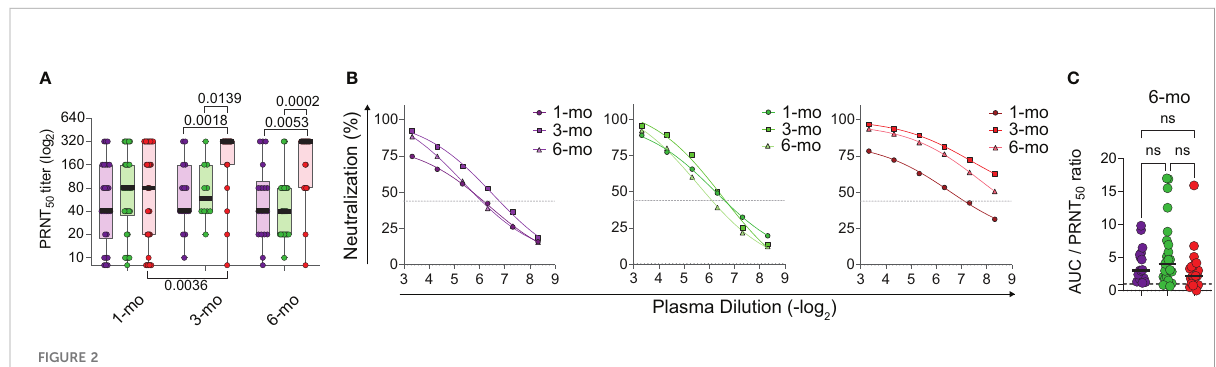
FIGURE 2 Longitudinal analysis of neutralizing antibody titers by PRNT. (A) Individual PRNT50 titers over time. (B) Comparison of mean neutralization curves at each collection point, per group. (C) Antibody potency analysis between groups through analysis of ratio between S RBD antibody/PRNT 50 antibody neutralization. Differences between patients ’ groups at the same collection point and differences between collection points were assessed by Kruskall Wallis ’ and Dunn ’ s post hoc test. ns, non-signi fi